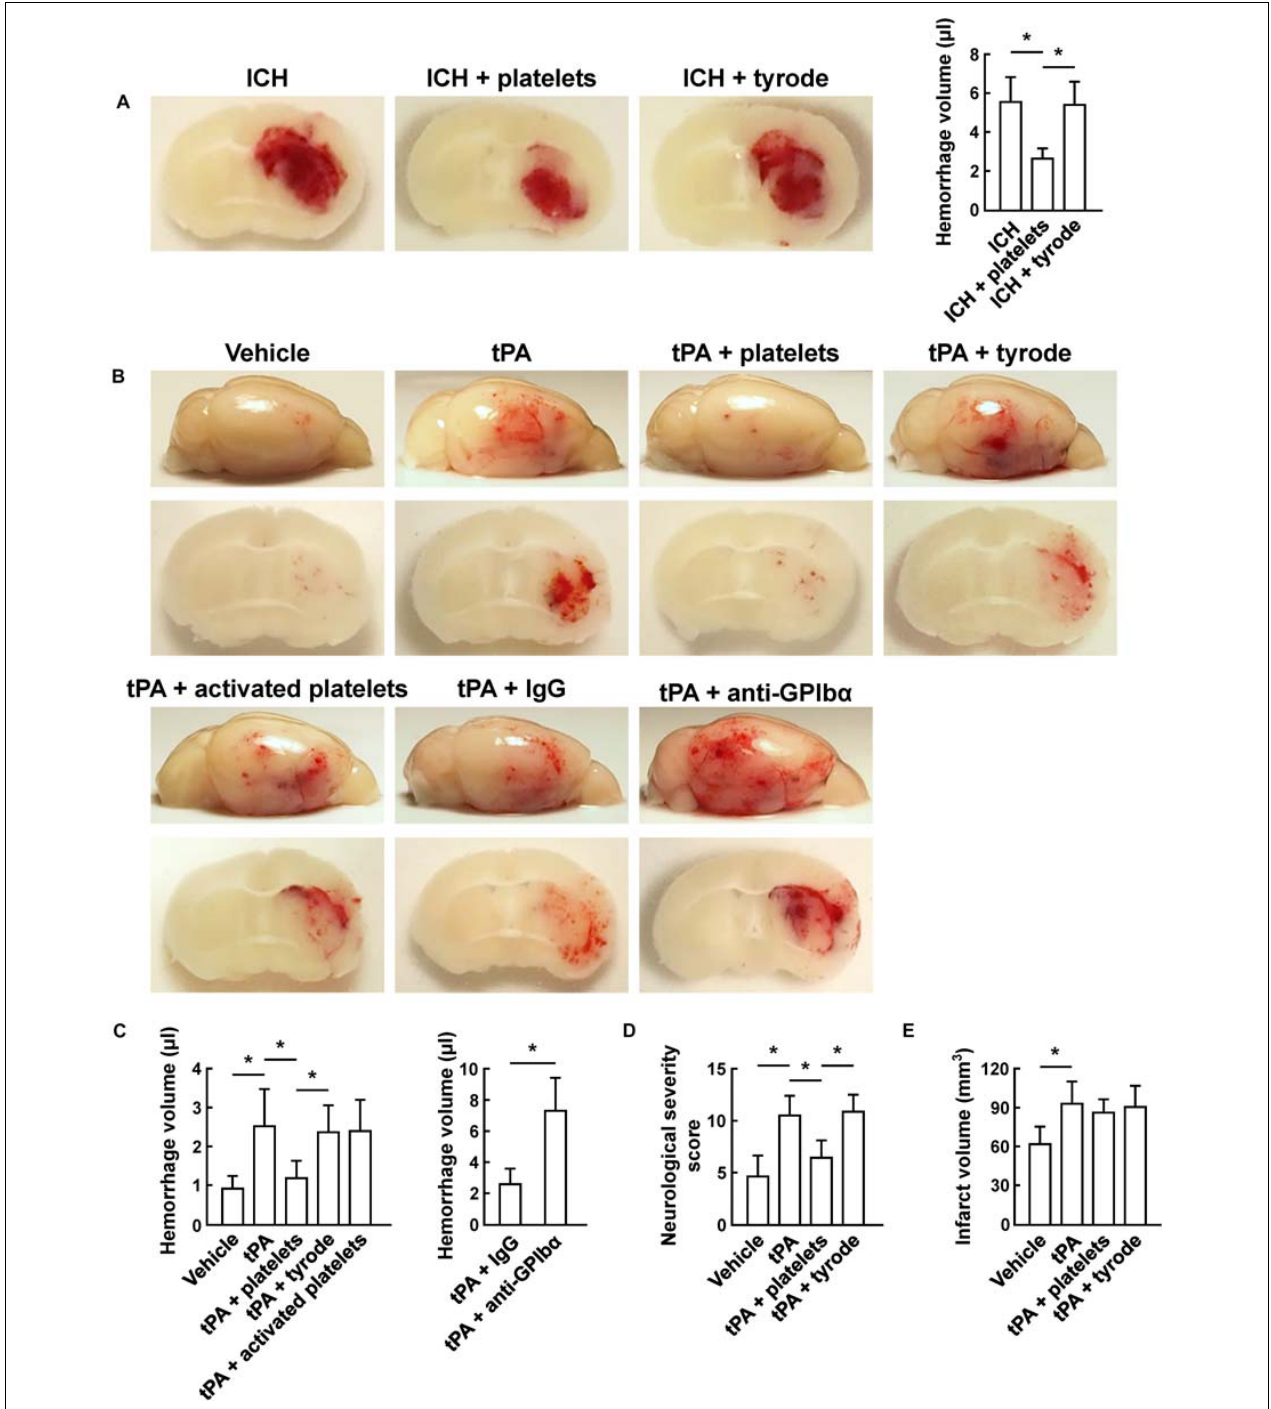
FIGURE 1 | Transfusion of resting platelets reduced hemorrhage volume after ICH and ischemic stroke. (A) Representative images of coronal sections and quantification of brain hemorrhage 24 h after collagenase-induced ICH in mice injected with vehicle, platelets and tyrode. n = 7 per group. (B) Representative images of the dorsal surface and coronal sections show brain hemorrhage 24 h after cerebral ischemia in mice treated with vehicle, tPA, tPA + resting platelets, tPA + tyrode buffer, tPA + activated platelets, tPA + control IgG, or tPA + platelet-depleting IgG (GPIb α ). (C) Quantification of cerebral hemorrhage for each group. n = 8 per group. (D) Neurological severity score (NSS) 24 h after cerebral ischemia in mice treated with vehicle, tPA, tPA + resting platelets, or tPA + tyrode buffer. n = 10 per group. (E) Quantitative analysis of infarction volume 24 h after cerebral ischemia in mice treated with vehicle, tPA, tPA + resting platelets, or tPA + tyrode buffer. n = 5 per group. Values are mean ± SD. ∗ P <